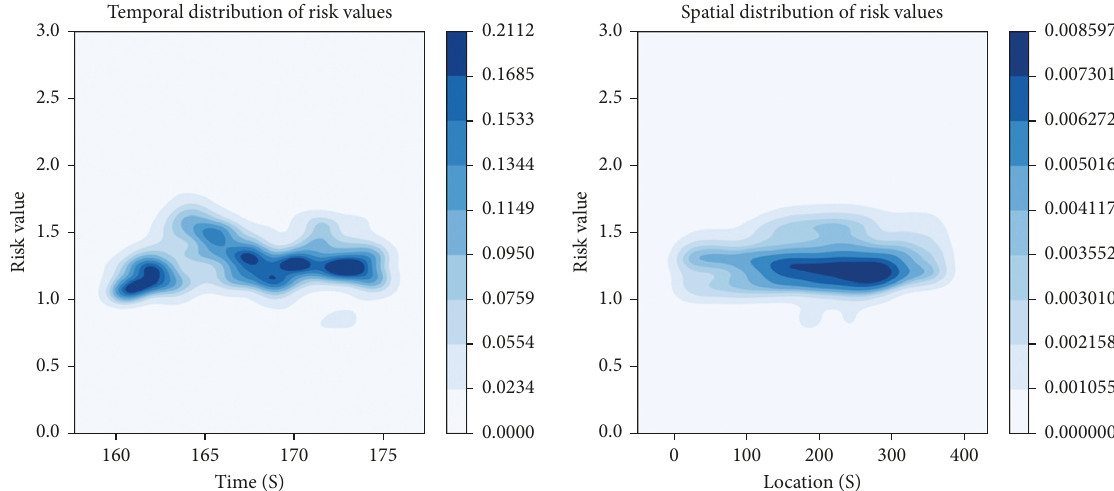
Figure 10: Temporal and spatial variation of risk values based on kernel density